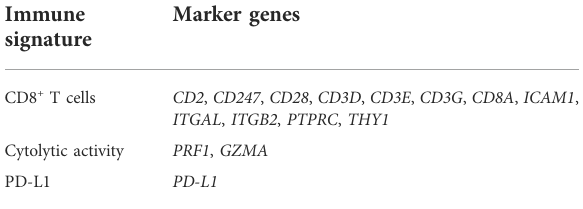
TABLE1Themarkergenesofthethreeimmunesignaturesanalyzedin this